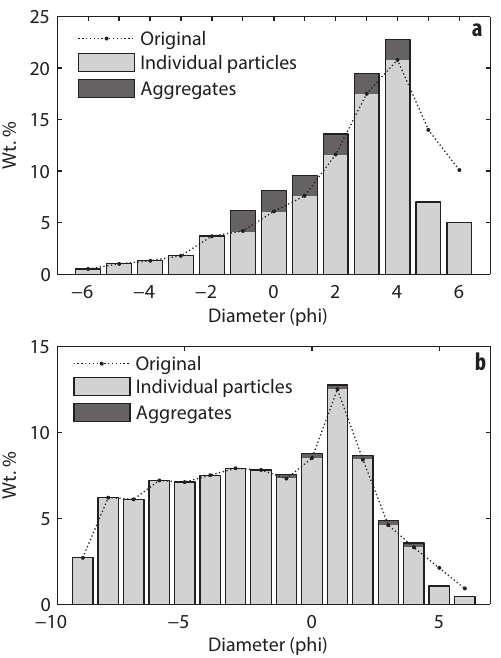
Figure 7. Original and aggregated TGSD of the 1875 Askja erup- tion based on Sparks et al. (1981) for (a) the phreato-Plinian phase Askja C and (b) the dry Plinian phase Askja D. See caption of Fig. 4 for explanation of